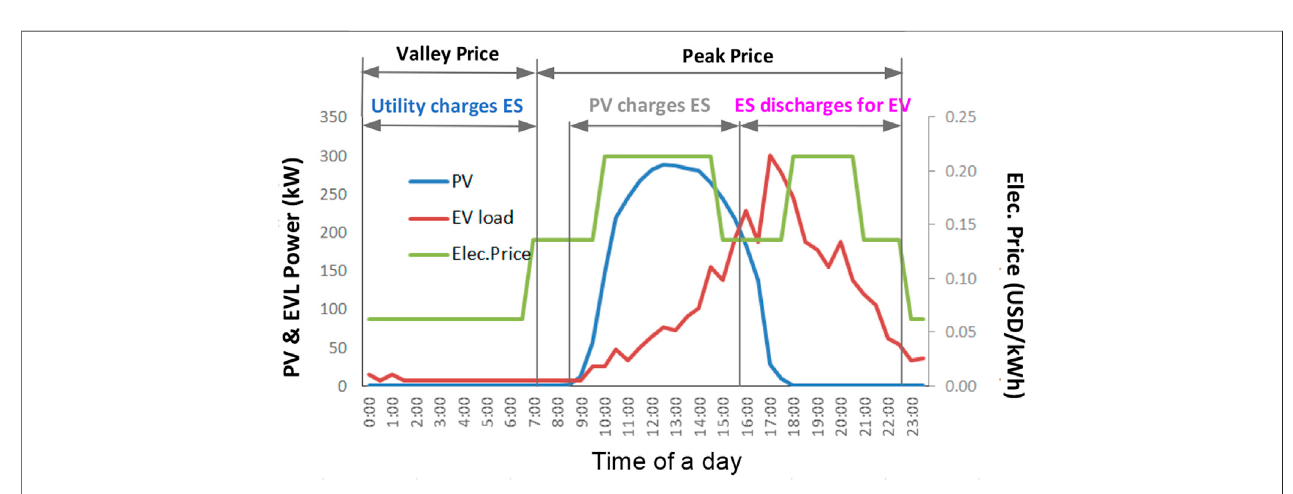
FIGURE 5 | Peak-valley electric price, PV and EV load in EVCS